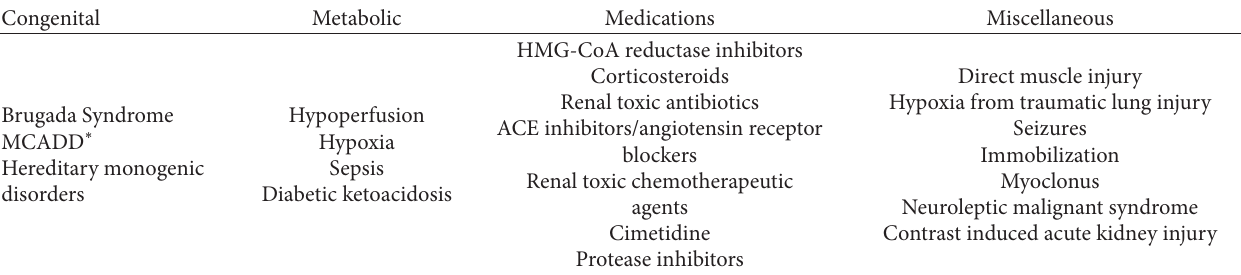
Table 4: Differential diagnosis of PRIS.